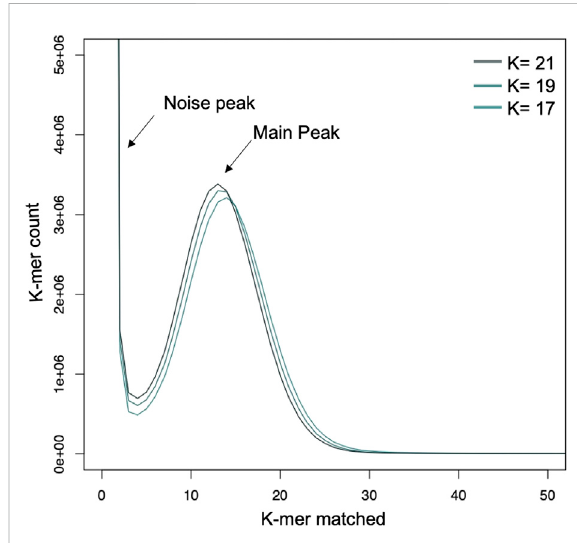
FIGURE 2 Genome estimation using k-mer analysis with 17-, 19- and 21-mers.Thek-mers showapeakatasimilarlocationwhichgives anestimateof35Xgenomecoverageandagenomesizeof48 MB for C . aff. paspali (H3